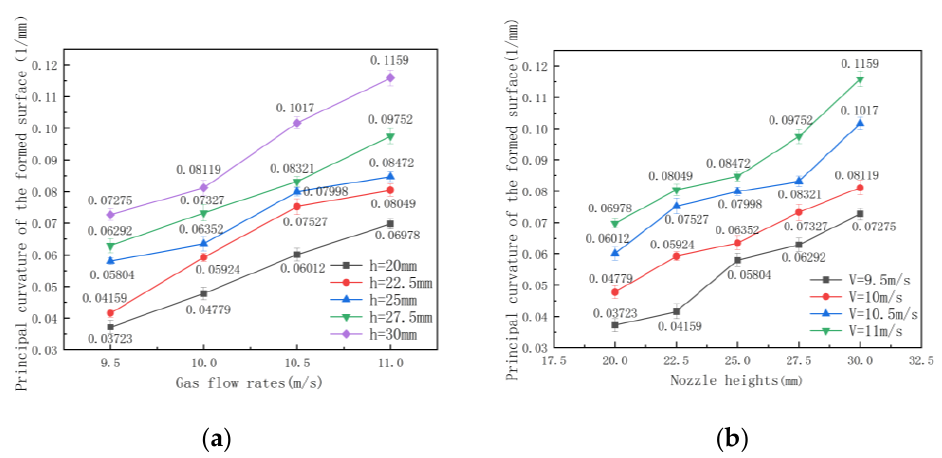
Figure 14. The principal curvature of the formed surface with different gas flow rates and nozzle heights in the experiments. ( a ) is the relationship between the gas flow rate and the principal curvature of the formed surface. ( b ) is the relationship between the nozzle height and the principal curvature of the formed surface.